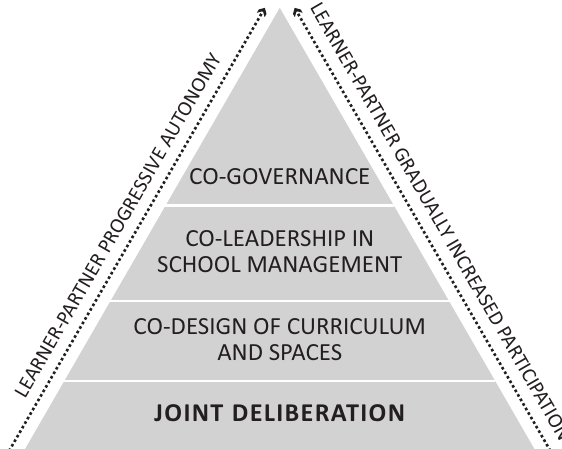
Figure 1. Learner‐partner gradually increased participation following their progressive